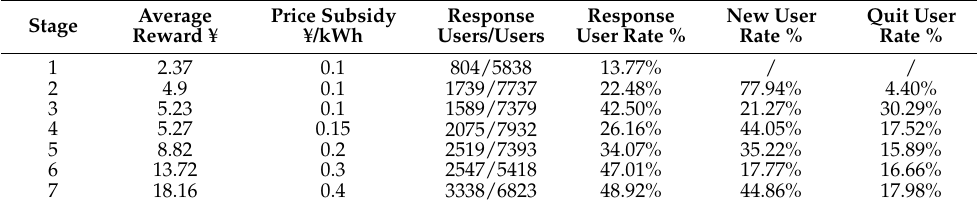
Table 2. User participation